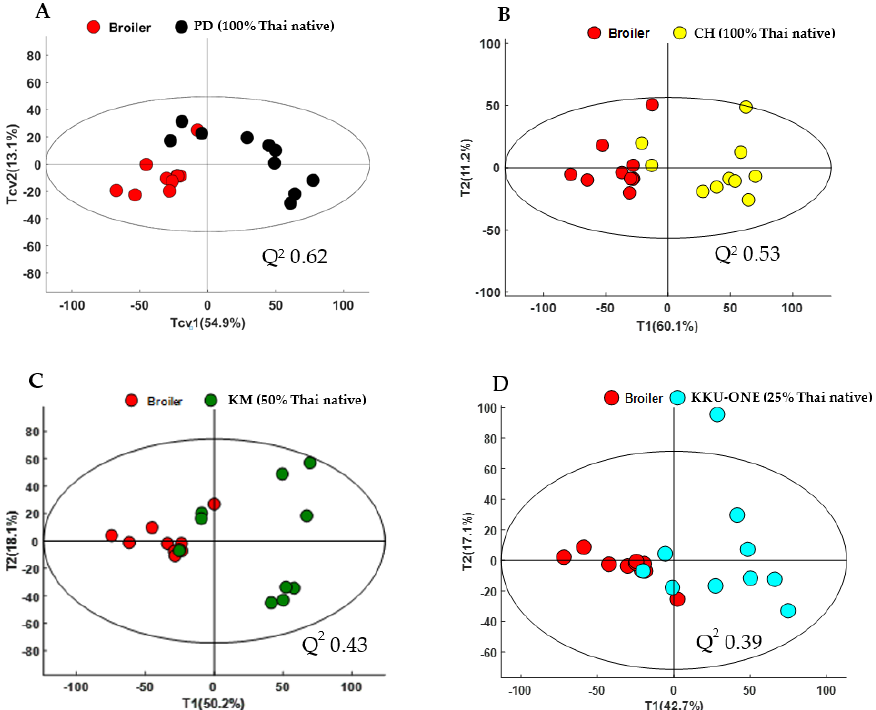
Figure 1. Principal component analysis (PCA) scores discriminating metabolites of chicken breast extracts of ( A ) commercial broilers versus PD = Pradu Hang Dam Mor Kor 55 (100% Thai native); Q 2 = 0.62, ( B ) commercial broilers versus CH = Chee KKU 12 (100% Thai native); Q 2 = 0.53, ( C ) commercial broilers versus KM = Khai Mook E-san (50% Thai native;); Q 2 = 0.43, and ( D ) commercial broilers versus KKU-ONE (25% Thai native); Q 2 = 0.39.